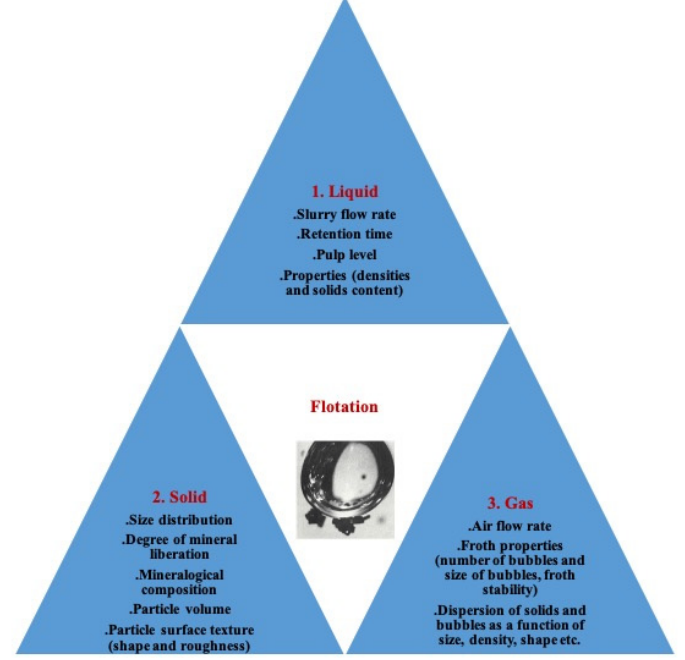
Figure 27. Phases and related factors affecting flotation, modified from [379].